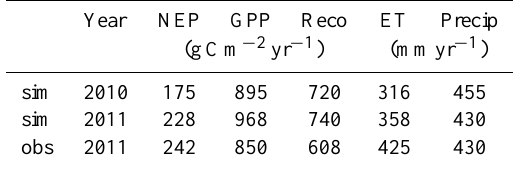
Table 3. Annual sums of net ecosystem productivity (NEP), gross primary productivity (GPP) and ecosystem respiration (Reco) de- rived from simulations with the SPA model (sim) and observations (obs) that were partitioned and gap-filled from measurements of net ecosystem exchange (available from March